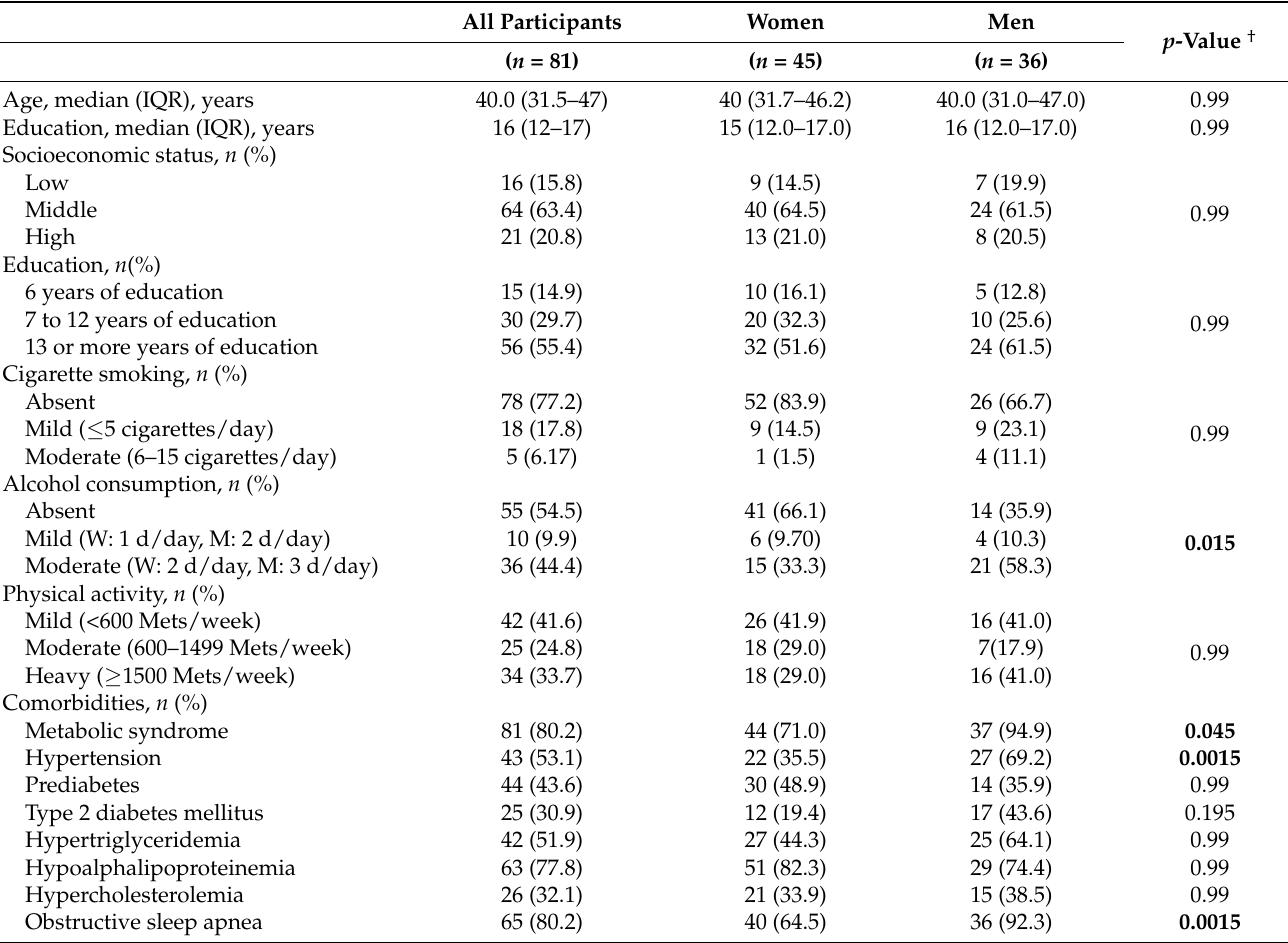
Table 1. Sociodemographic and clinical characteristics. All